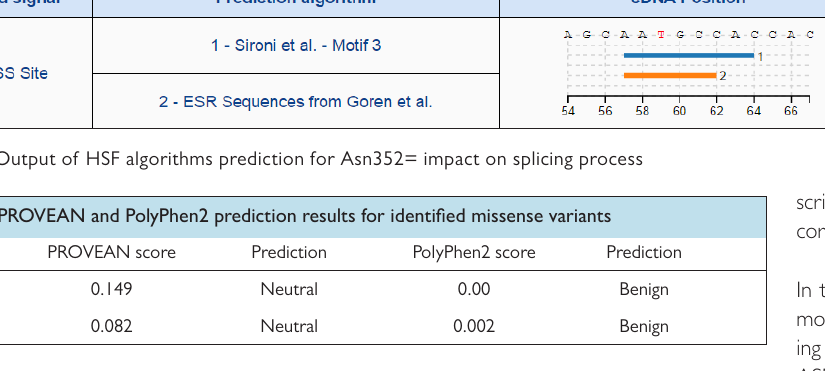
Table 3. Comparison of GATA4 mutation rates between different ASD populations